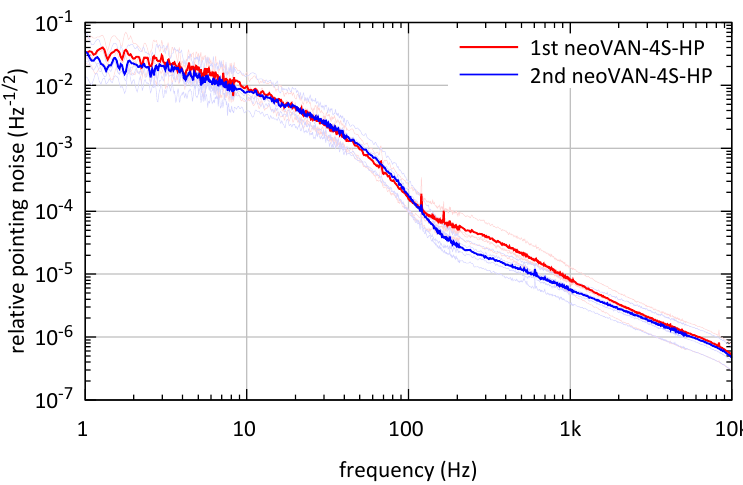
Figure 10. Relative beam pointing noise measurements of the beam amplified by the first and second neoVAN-4S-HP amplifier,